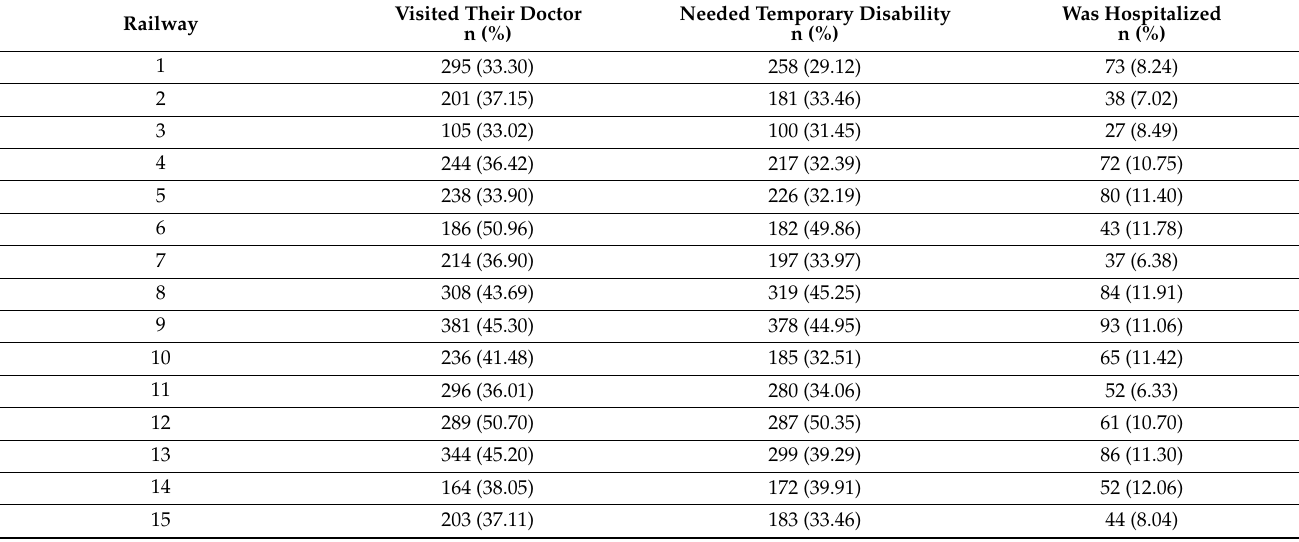
Table 4. Self-reported medical activity during last year by